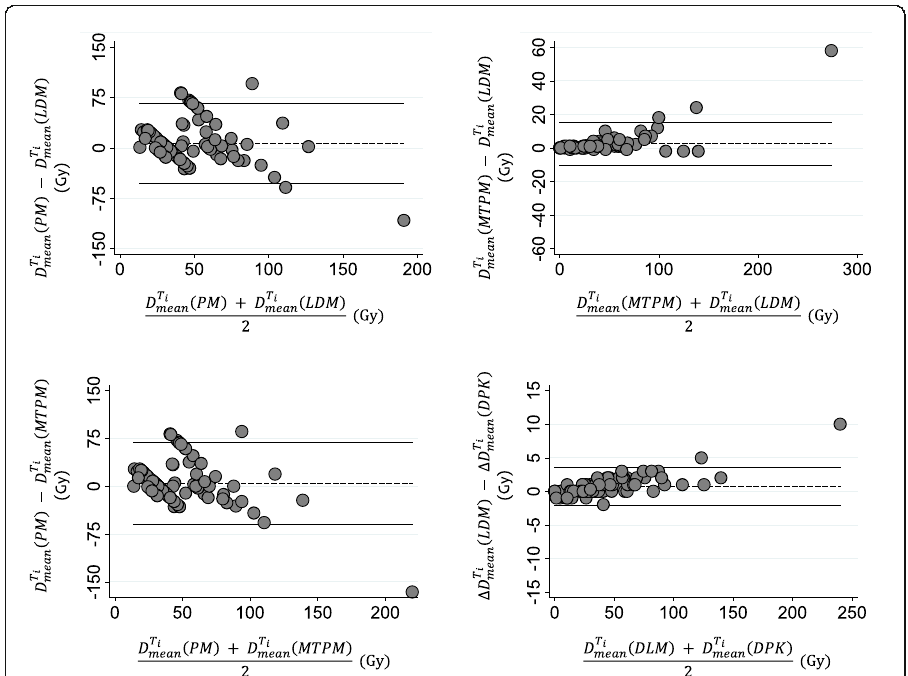
Fig. 8 Bland-Altman diagrams representing the relative dose difference in Gy between the studied dosimetry methods versus the mean dose values in Gy for each individual tumor by pairs. The dashed line represents the average of the differences between the studied dosimetry methods, and the black line is the mean differences of ± 2